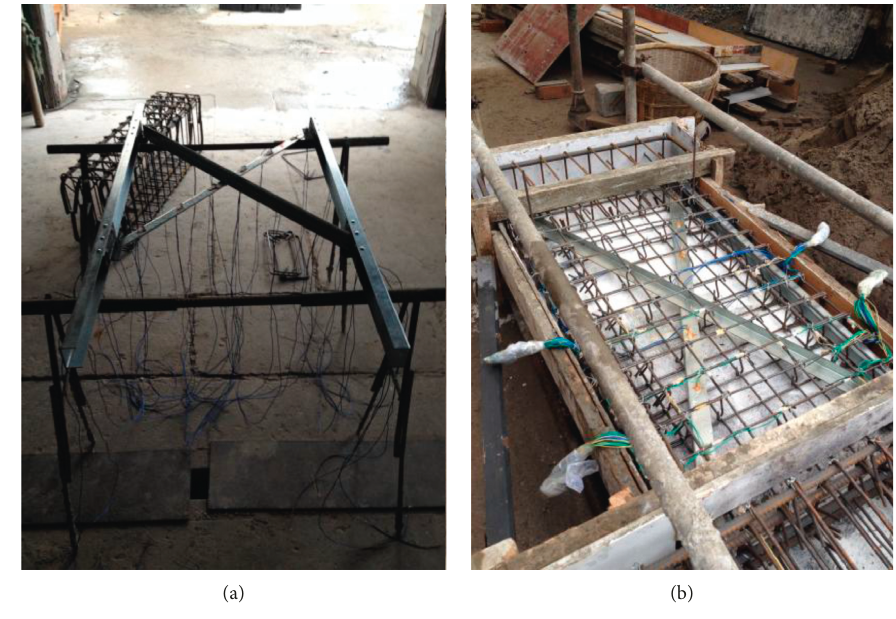
Figure 6: Test specimen before pouring concrete.